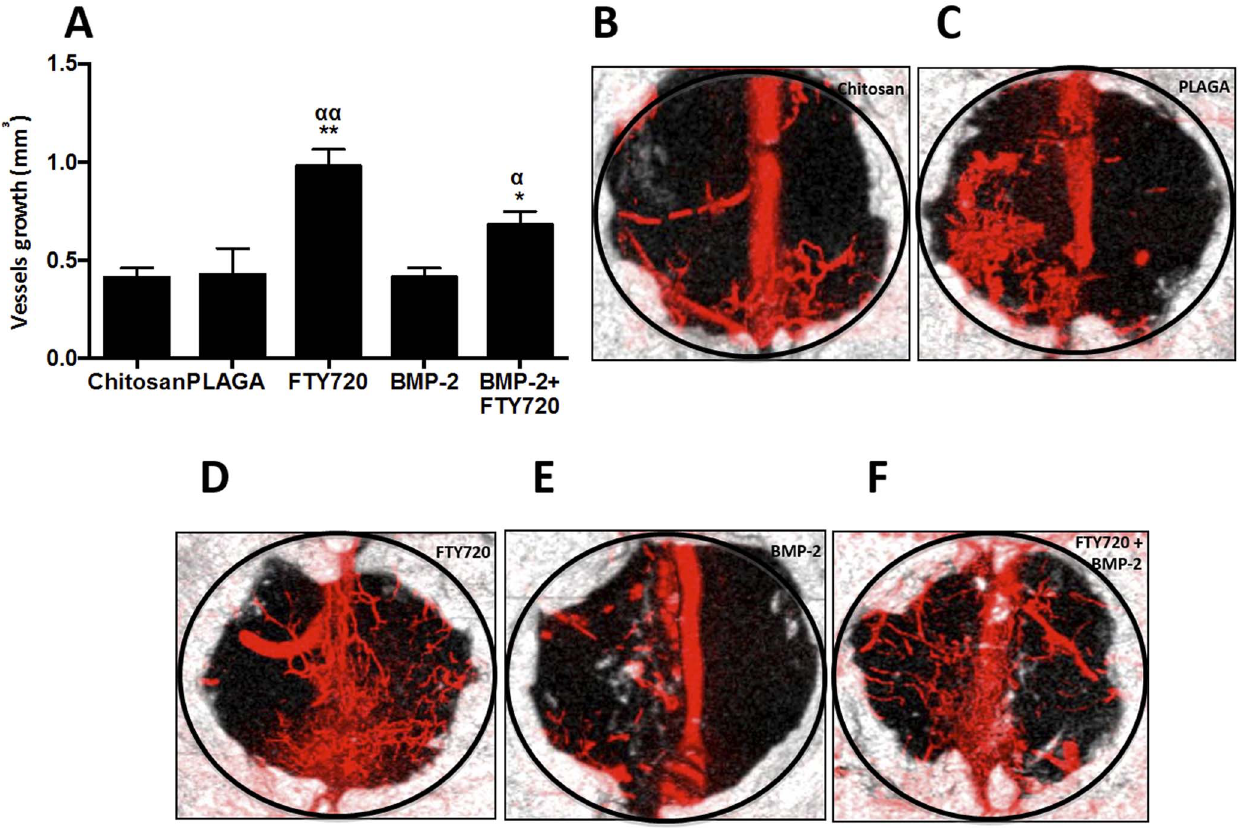
Figure 7. FTY720 enhances vascularization in a critical size cranial defect. (A) Vascularization in the critical size cranial defect measured using microfil enhanced microCT imaging. (B–F) Volume in the defect region occupied by vessel ingrowth 9 weeks after different treatments (** p , 0.01 & *p , 0.05 compared to chitosan control; aa p , 0.01 & a p , 0.05 compared to PLAGA control) MicroCT images showing vessel and bone in- growth at week 9 for animals treated with (B) Chitosan, (C) Chitosan + PLAGA microspheres, (D) Chitosan + PLAGA microspheres loaded with FTY720, (E) Chitosan loaded with BMP-2 and (F) Chitosan loaded with BMP-2 + PLAGA microspheres loaded with FTY720.